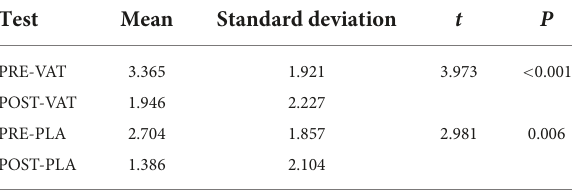
TABLE 6 Pre-test post-test difference for VAS-M in experimental (VAT) and control (placebo) group (VAS-M, visual analogue scale for